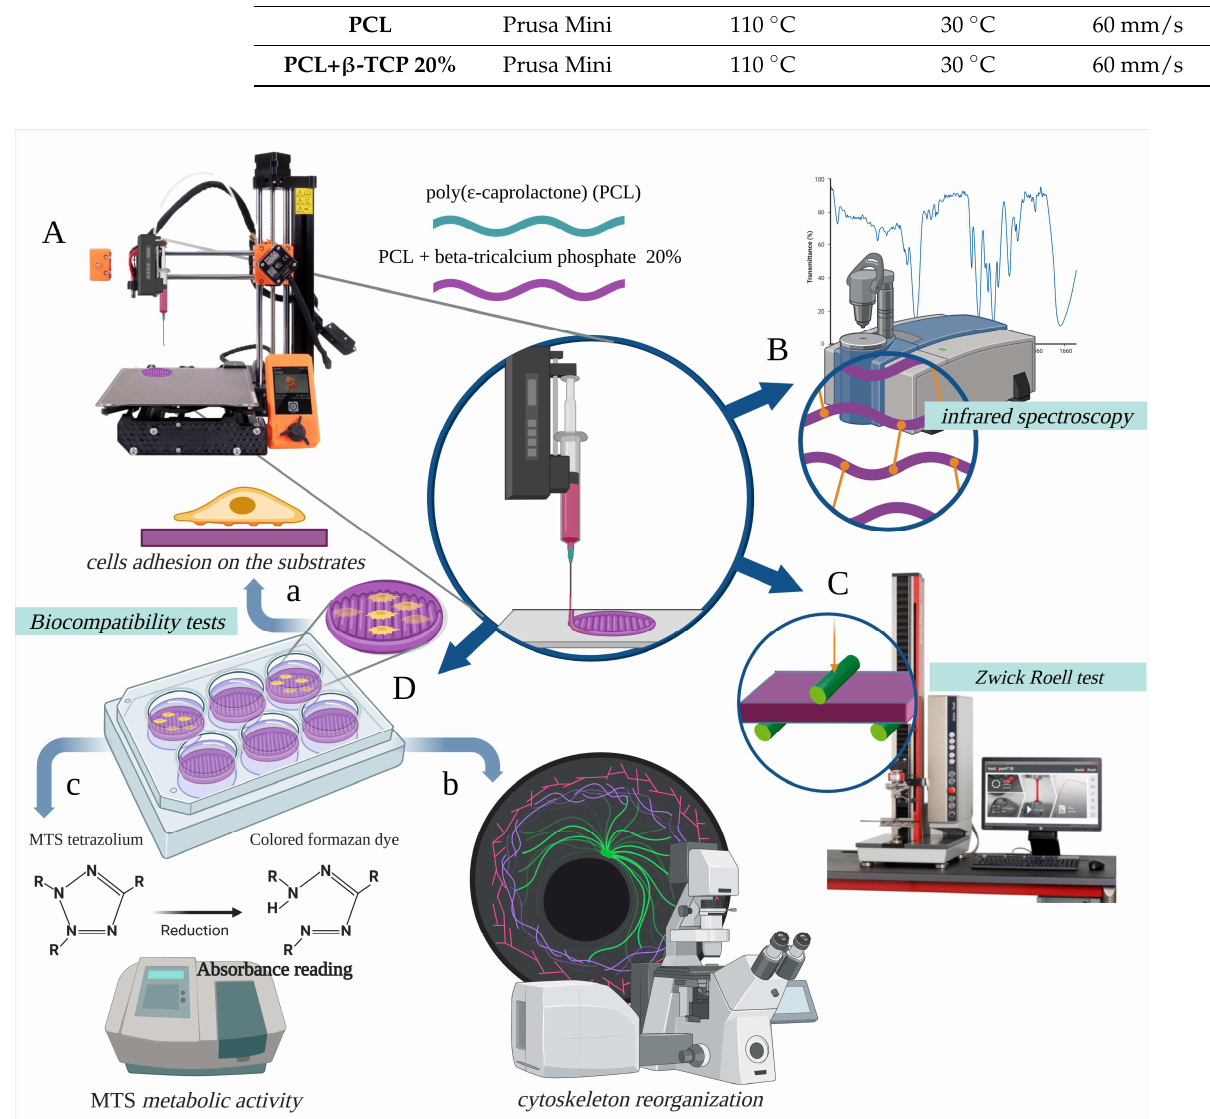
Figure 1. The poly(ε-caprolactone) (PCL) polymer and the PCL compounded with beta-tricalcium Figure 1. The poly( ε -caprolactone) (PCL) polymer and the PCL compounded with